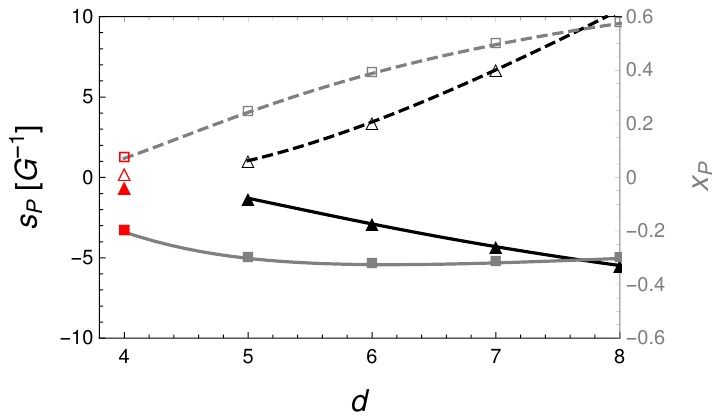
Figure 3 . Real and imaginary parts of s P (using the left vertical axis) as functions of d plotted using dashed and solid (black) lines, respectively. The empty and filled triangles show the values for integer d where, for d = 4 , the value log a = 1 has been chosen. We also plot the real and imaginary parts of x for the graviball ( x P , using the right vertical axis) with dashed and solid (gray) lines, respectively. The empty and full squares are the corresponding values for integer d